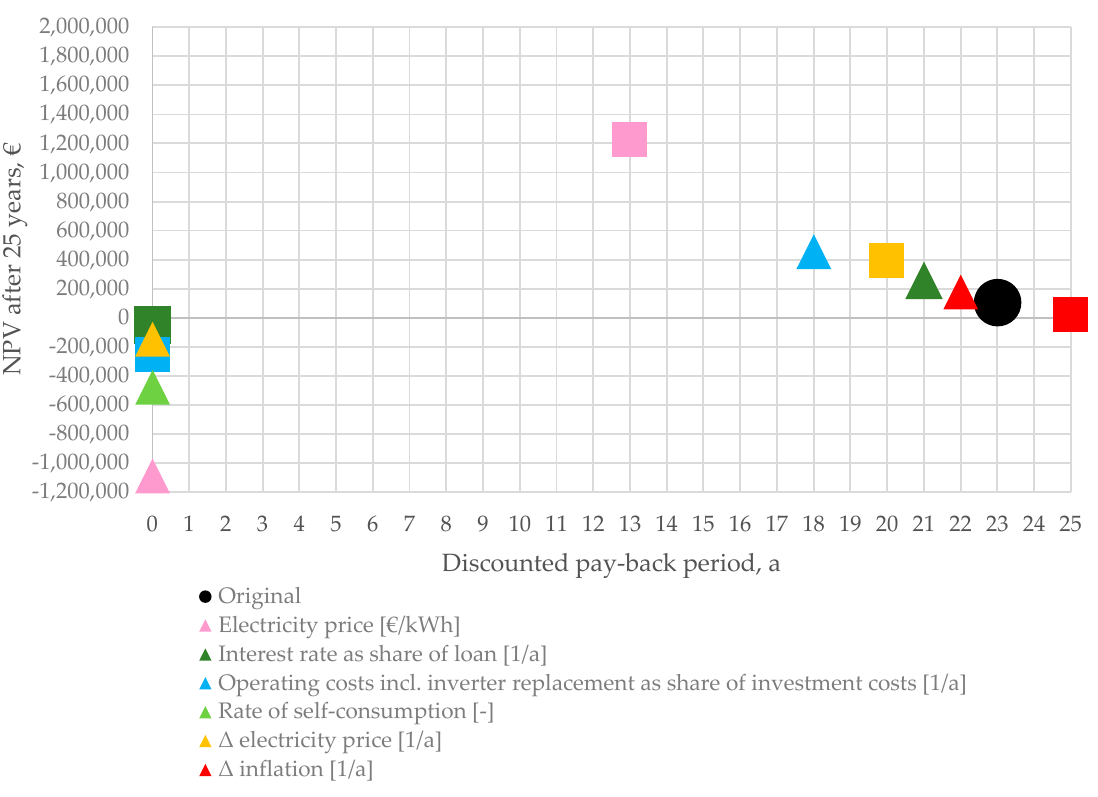
Figure A4. Sensibility analysis of Case 1 CPI-financing.